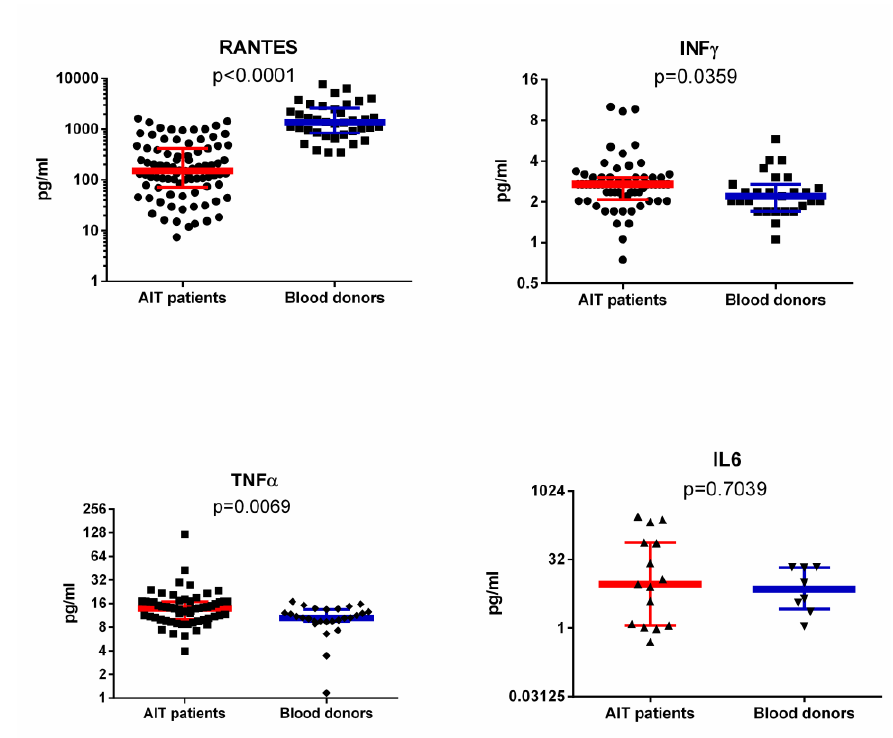
Figure 3. RANTES, IFN γ , IL-6, and TNF α median levels (error bars indicating IQR) in the plasma of AIT patient and blood donor groups. Chemokine (RANTES) and pro-inflammatory cytokine (IFN γ , IL-6 and TNF α ) levels from SMIA investigations are expressed as pg / mL. IFN γ , IL-6 and TNF α were chosen as they participate in RANTES induction.